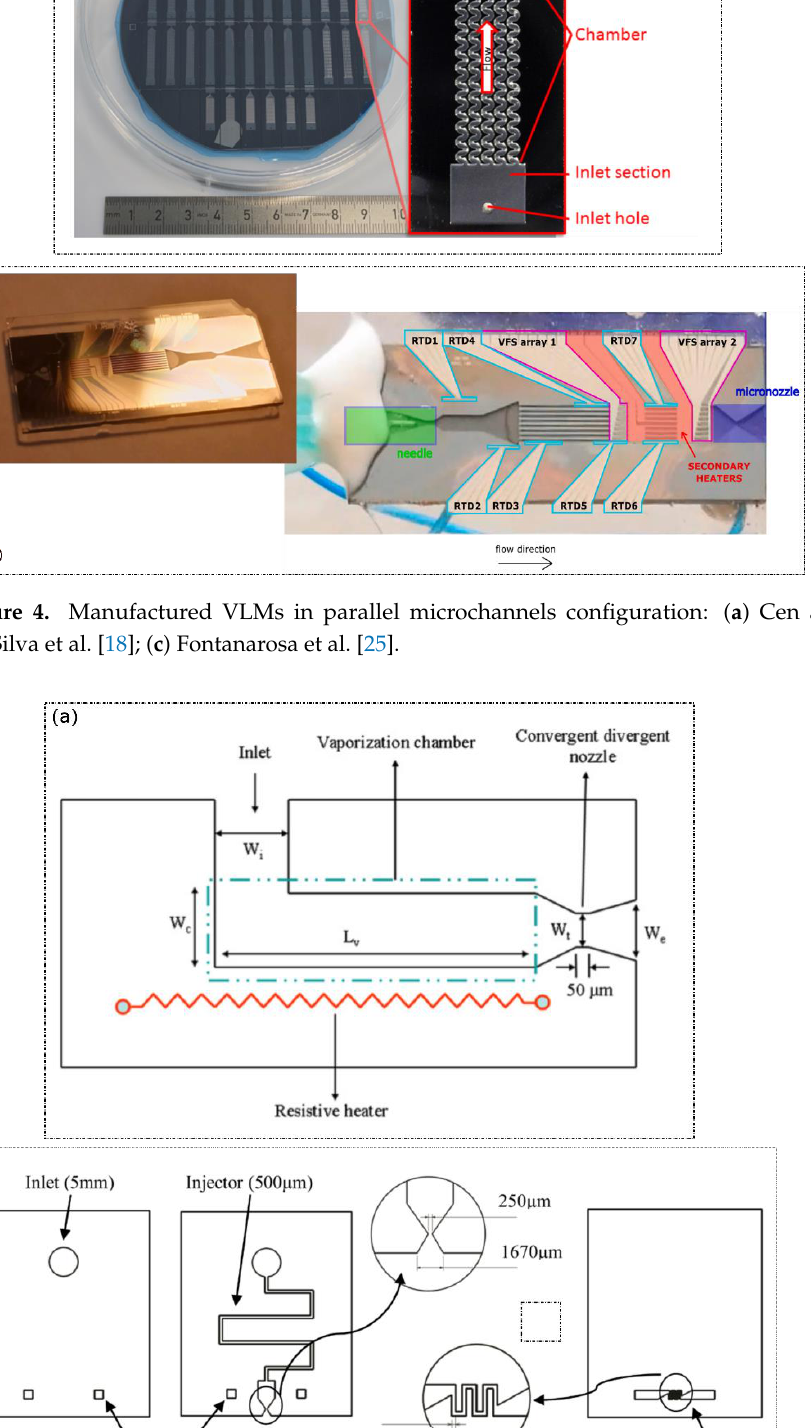
Figure 5. Manufactured VLMs in single channel configuration: ( a ) Karthikeyan et al. [20]; ( b ) Cheah and Low [21]; ( c ) Liu et al. [23]; ( d ) Kwan et al. [24].